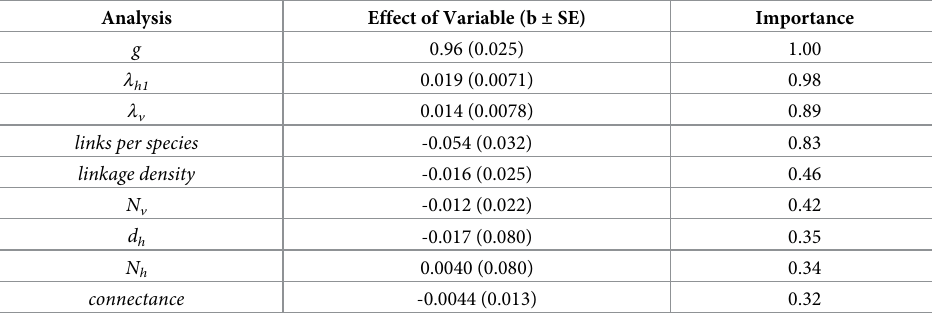
Table 3. Model averaged effects of six variables on modularity